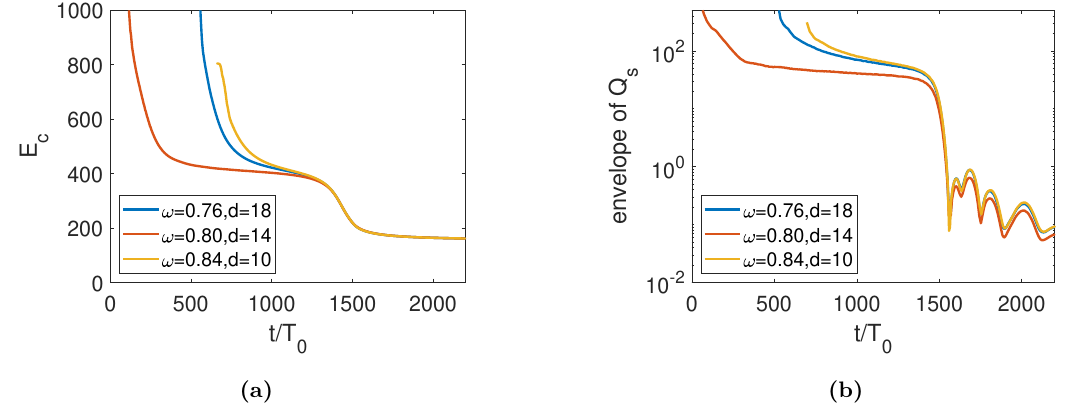
Figure 31. Attractor behavior of the dipole CSQ in 3+1D. The initial configurations are super- imposed elementary Q-balls. Initial configurations close to ω = 0 . 80 , d = 14 have longer lifetimes.